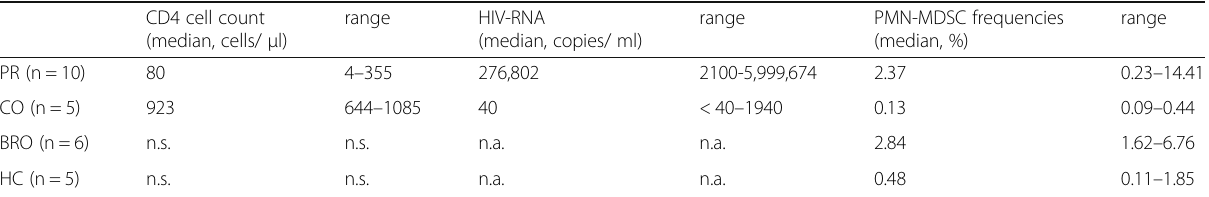
Table 1 Characteristics of the study subjects at blood draw CD4 cell count range HIV-RNA (median, cells/ μ l) (median, copies/ ml)